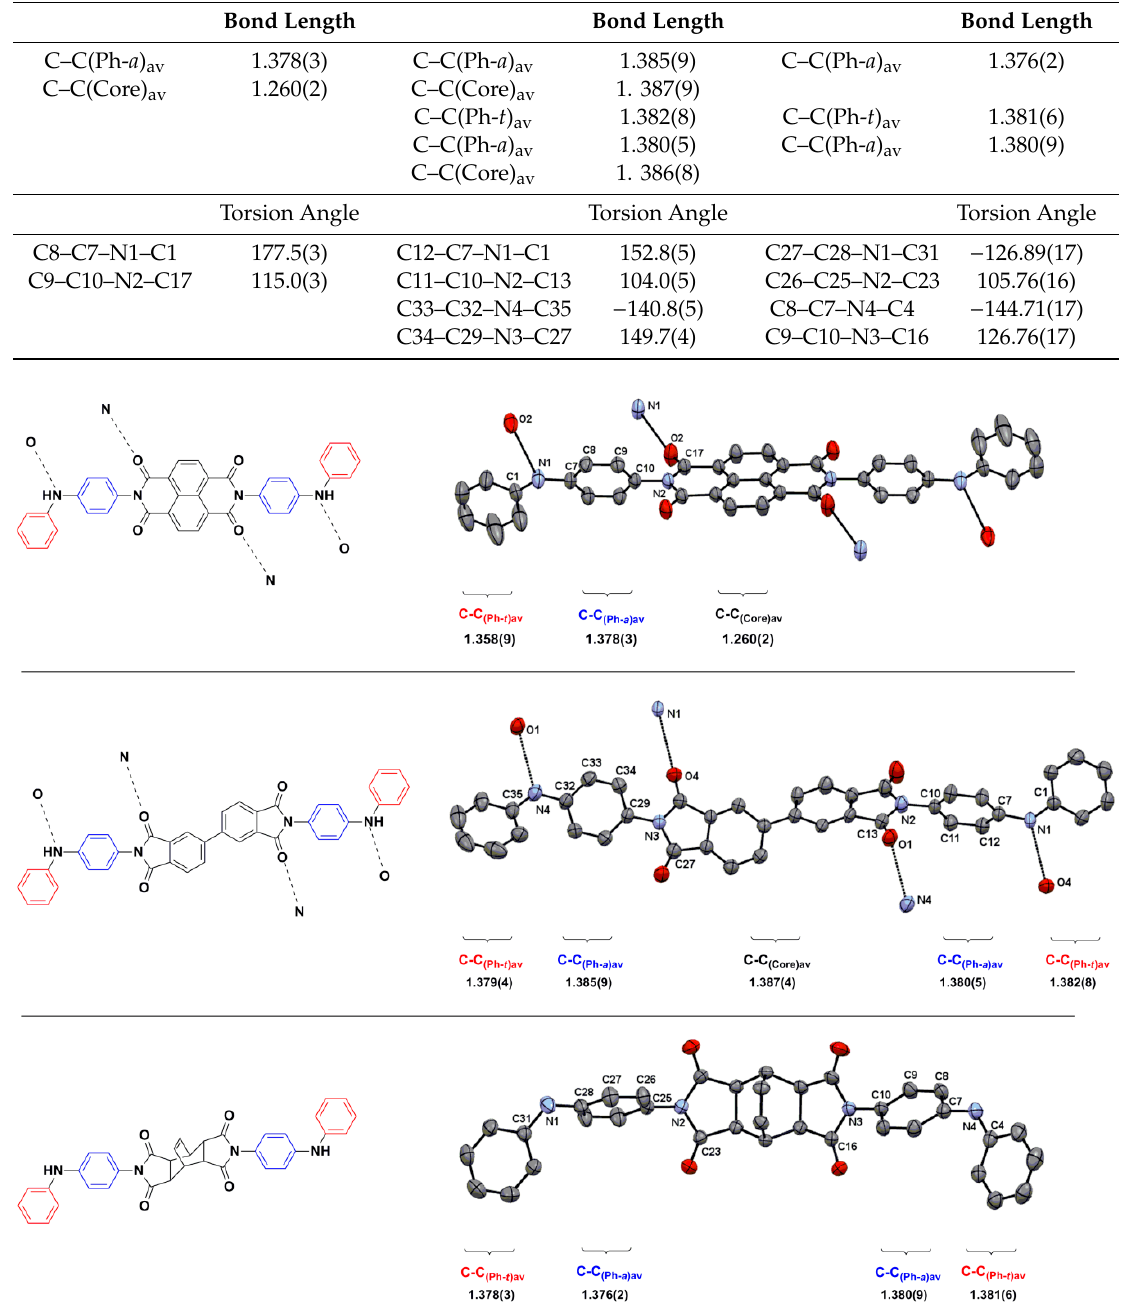
Figure 1. Schematic diagrams of intermolecular N ··· O hydrogen bonding interactions that appeared in diimide compounds for 1 (top left), 3 (middle left), and 5 (bottom left). ORTEP structures of 1 (top right), 3 (middle right), and 5 (bottom right) were presented with intermolecular N ··· O hydrogen bonding interactions. Solvent DMF molecules in 1 were deleted for clarity. Ph- t represented the terminal phenyl unit and Ph- a represented the adjacent phenyl unit relative to core.